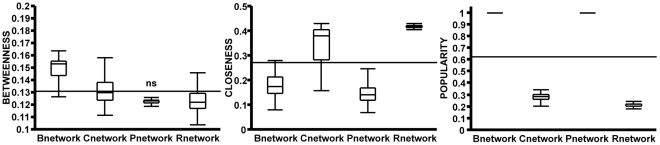
Comparing maximum attainable centrality across networks.With the exception of B-centrality in P-networks (labeled as ns), all affiliation preferences raised values of P- and B-centrality metric above those recorded in R-networks. In contrast, none of the affiliation-driven networks were able to raise the values of C-centrality above those recorded in R-network. The box plots indicate descriptive statistics: median, quartiles, maxima and minima; horizontal line in each graph indicates the grand mean for the respective centrality metric.